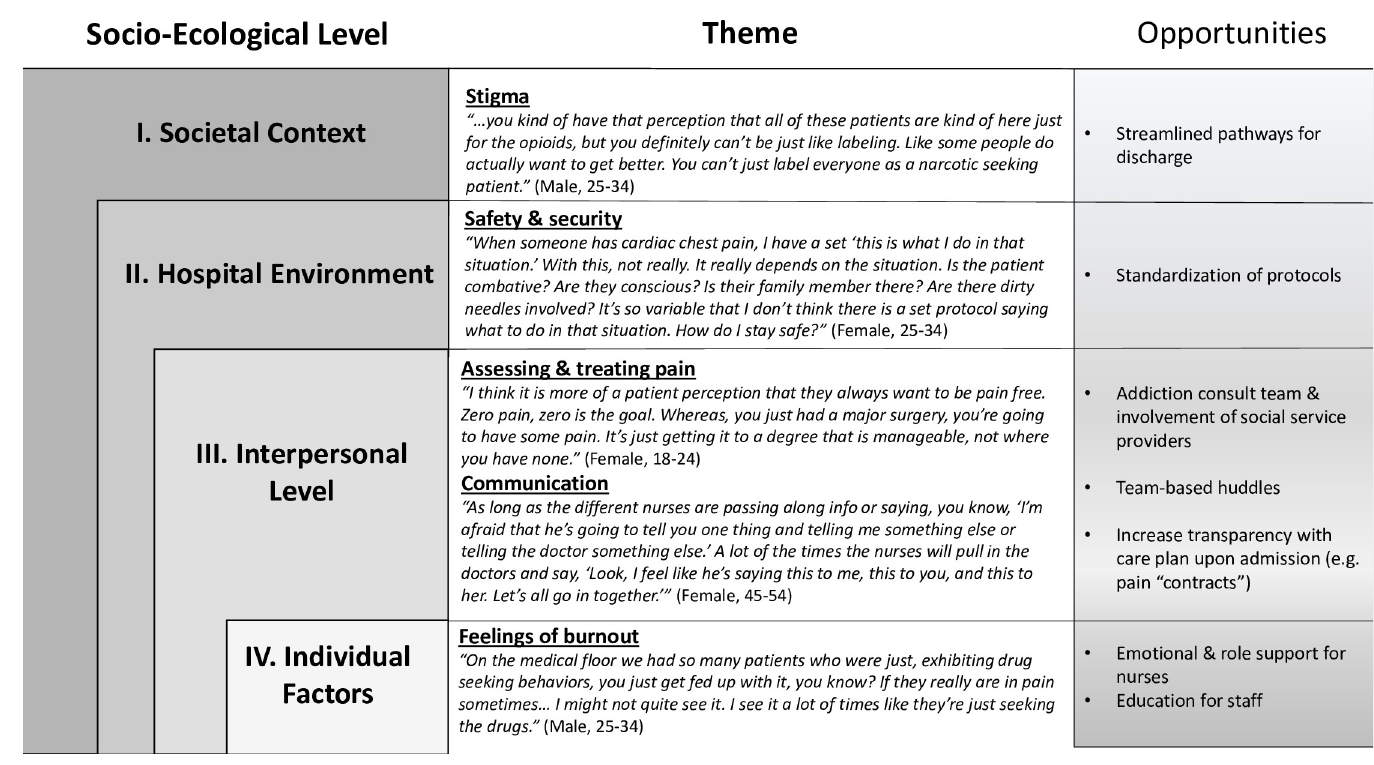
Fig 1. Themes from qualitative interviews organized within the Socio-Ecologic framework with supporting quotes.